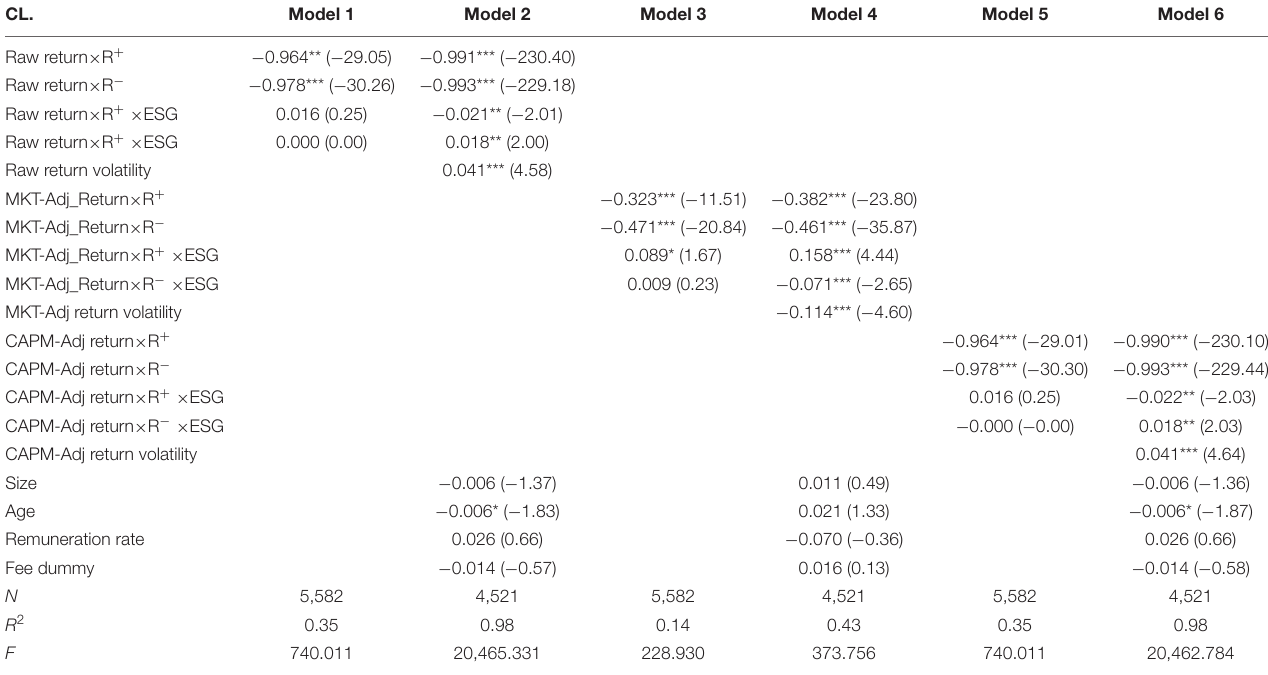
Table 4 is the result of regression analysis (OLS) of fund flow–performance sensitivity according to the type of past fund performance. The dependent variable is fund flow. Raw return is the average of returns over the previous 12 months; MKT-Adj return, the market-adjusted returns over the previous 12 months; CAPM-Adj return, CAPM-adjusted return over the previous 12 months; Raw return volatility, the volatility of raw return over the previous 12 months; MKT-Adj return volatility, the volatility of the market-adjusted returns over the previous 12 months; CAPM-Adj return volatility, the volatility of CAPM-adjusted returns over the previous 12 months; ESG, a dummy that shows whether it is an ESG fund; Size, the natural logarithm of the size of the assets operated by the fund; Age, the age; Remuneration rate, the natural logarithm of a fee; and Fee dummy, the front-end fee dummy. The content of the table is the regression coefficient value; the figure in parentheses, t-value; and ***, **, and *